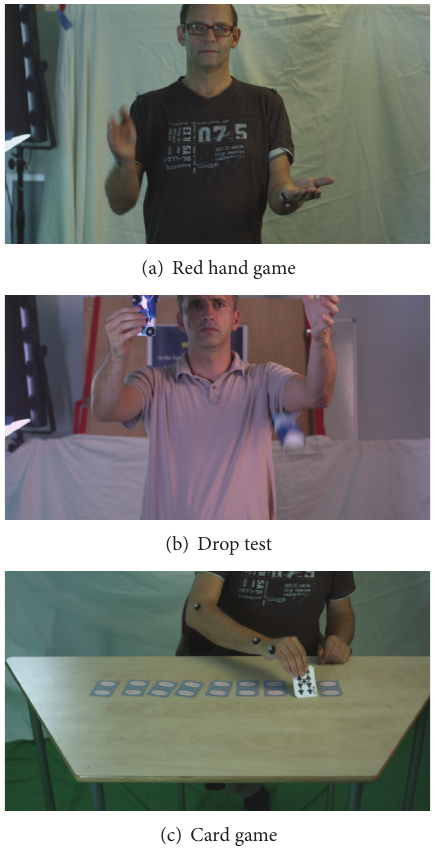
Figure 3: Games applied in the